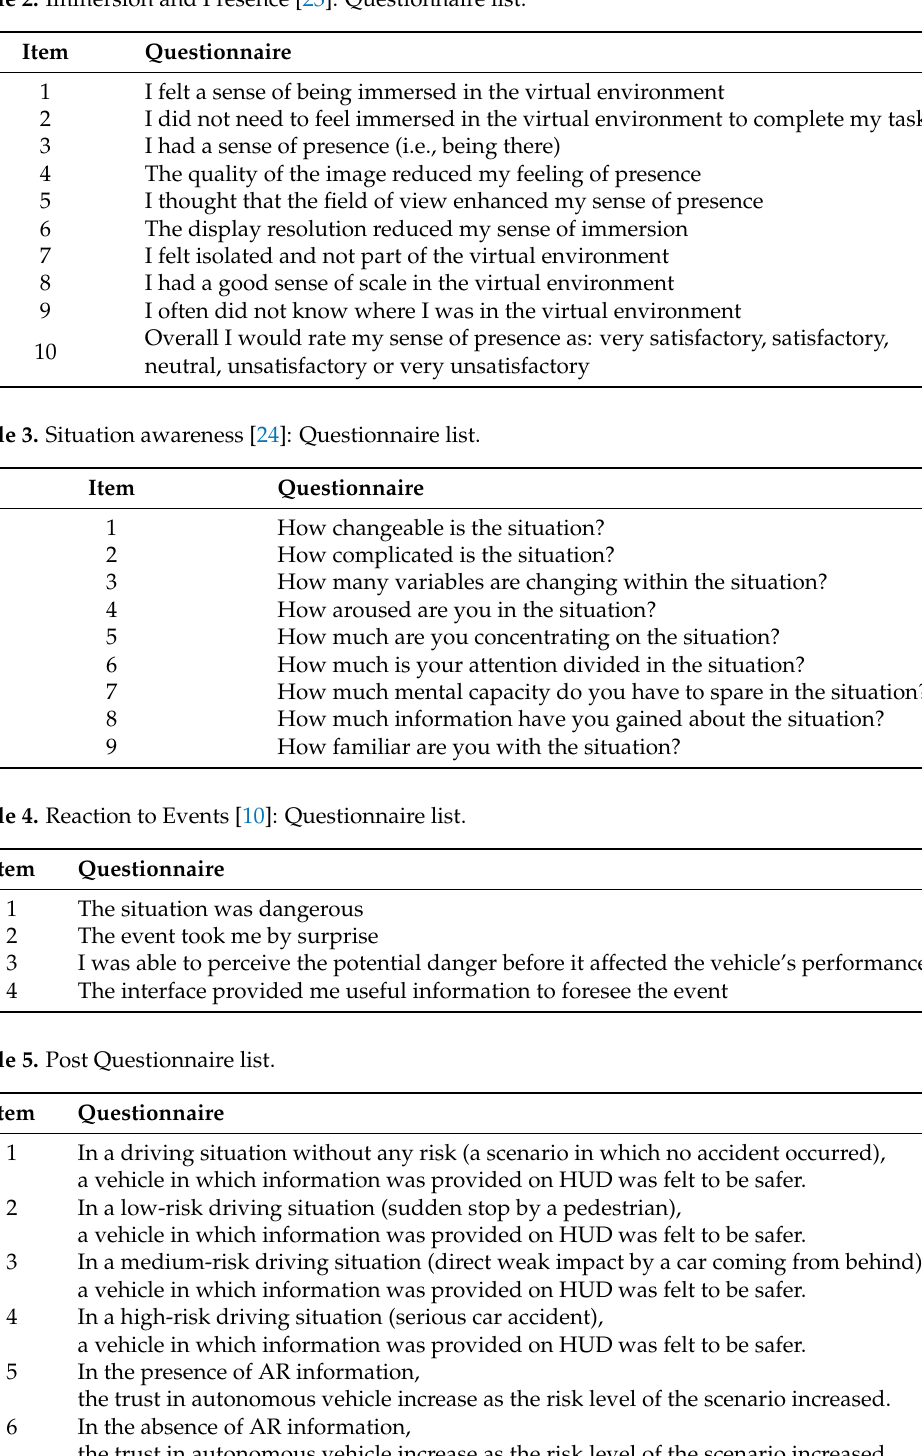
Table 2. Immersion and Presence [23]: Questionnaire list.